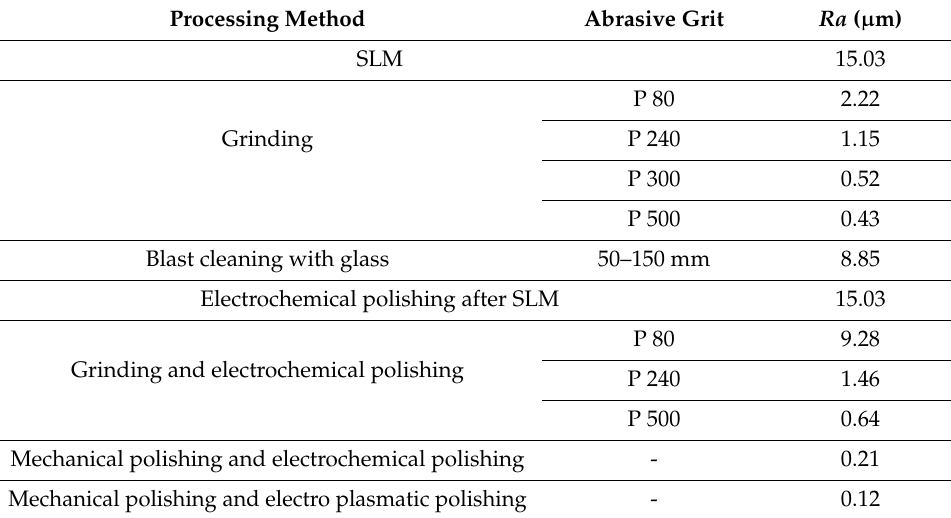
Table 2. Results of roughness measurements for elements from 316L steel manufactured in the SLM (Selective Laser Melting) technology, after selected processing methods [62].